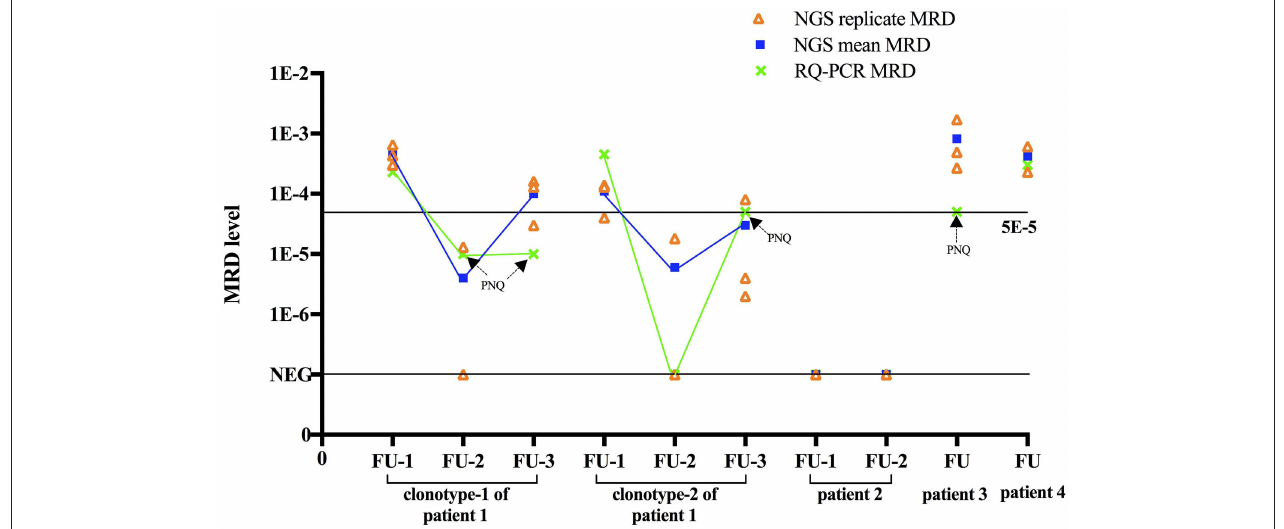
FIGURE 2 | Comparison between NGS and RQ-PCR. For each MRD sample, NGS based MRD of triplicates, mean MRD and ASO RQ-PCR based MRD are shown. For comparison purposes, cases that were defined as “positive not quantifiable” in ASO RQ-PCR were placed to sensitivity of that patient (10 − 5 for clonotype-1 of patient 1, 5 × 10 − 5 for clonotype-2 of patient 1 and patients 3). Aberration: FU, follow-up; PNQ, positive not